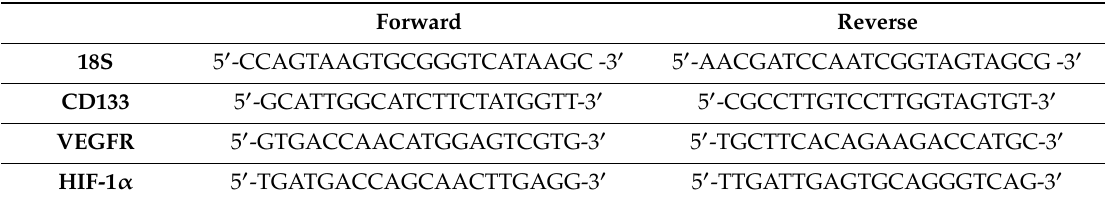
Table 1. Sequences of the primers used in